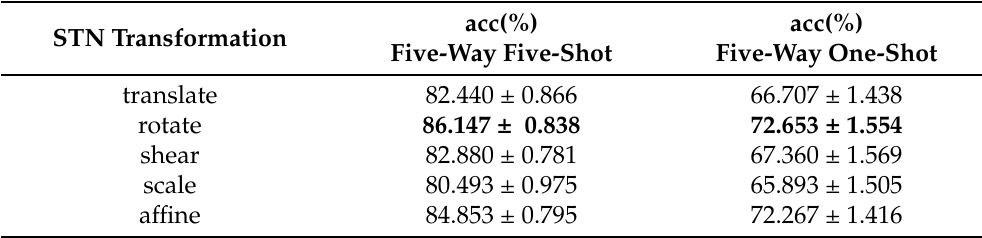
Table 6. Experiments on five kinds of spatial transformations in